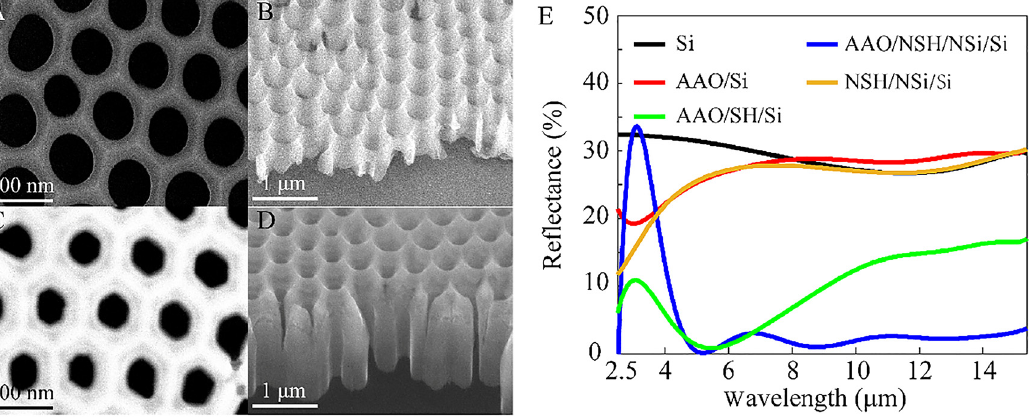
Figure 2: (A) Top view and (B) 45 ° view SEM images of the AAO/Si structure. (C) Top view and (D) 45 ° view SEM images of the AAO/NSH/NSi/Si structure. (E) Re fl ectance spectra of different structures: Planar Si (black line), planar Si with AAO (red line), AAO/SH/Si structure (green line), AAO/NSH/NSI structure (blue line), and NSH/NSI structure (yellow [34], we calculated the re fl ectance and transmittance of our devices. Figure 1(E) depicts the calculated absorption spectra for s - and p -polarized light as dashed lines. The results agree well with the measured absorption spectra.